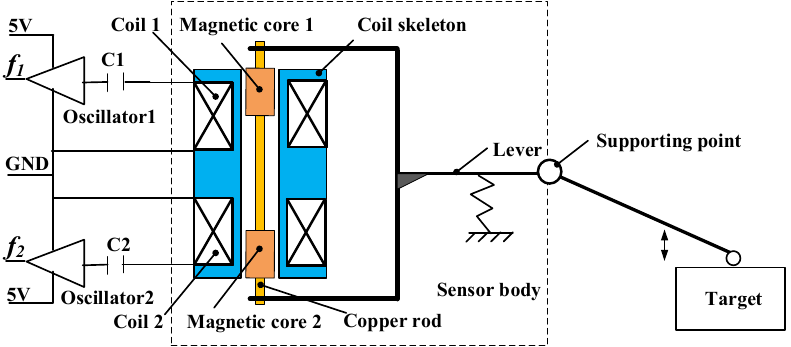
Figure 1. Working principle of the lever ‐ type DIFOD sensor.